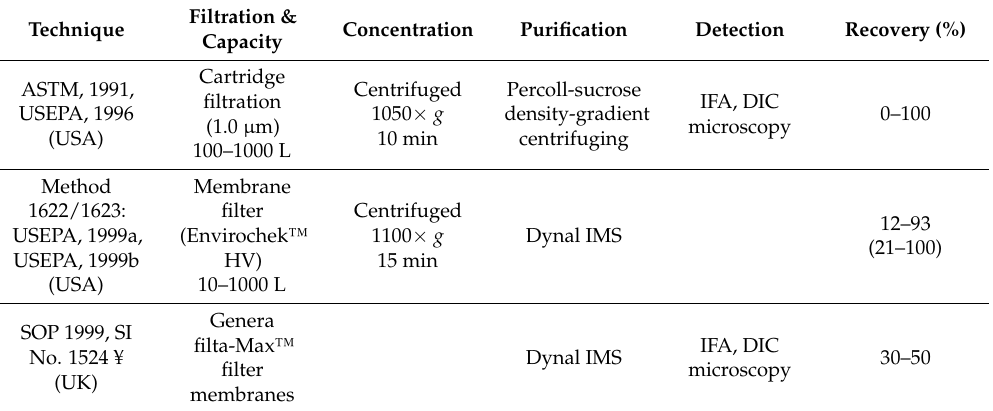
Table 1. Molecular approaches to detect Cryptosporidium oocysts in water [15].